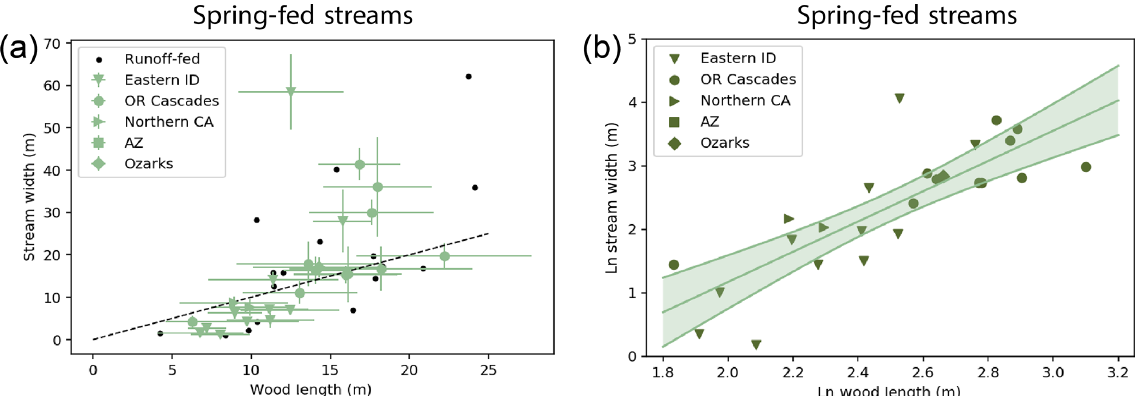
Figure 6. Wood length and stream width were measured using © Google Earth Pro satellite imagery. The relationship between wood length and stream width for spring-fed streams is shown (a) on a plot with width equal to length shown as a dashed line and error bars showing the standard deviation and runoff-fed streams marked with black dots (error bars left off for clarity of viewing) and (b) on a ln − ln plot with the line of best fit ( w = al c with a = 0 . 45 ± 0 . 63 and c = 1 . 39 ± 0 . 52), error bars and runoff-fed streams left out for clarity. The 95% confidence interval for the line of best fit is shaded. In both panels, the data symbols represent the geographic locations of the streams. There is no apparent significant clustering by location. In panel (a) , streams that fall above the dotted line are wider than the wood load entering the streams, whereas the streams falling below the line are narrower than the wood